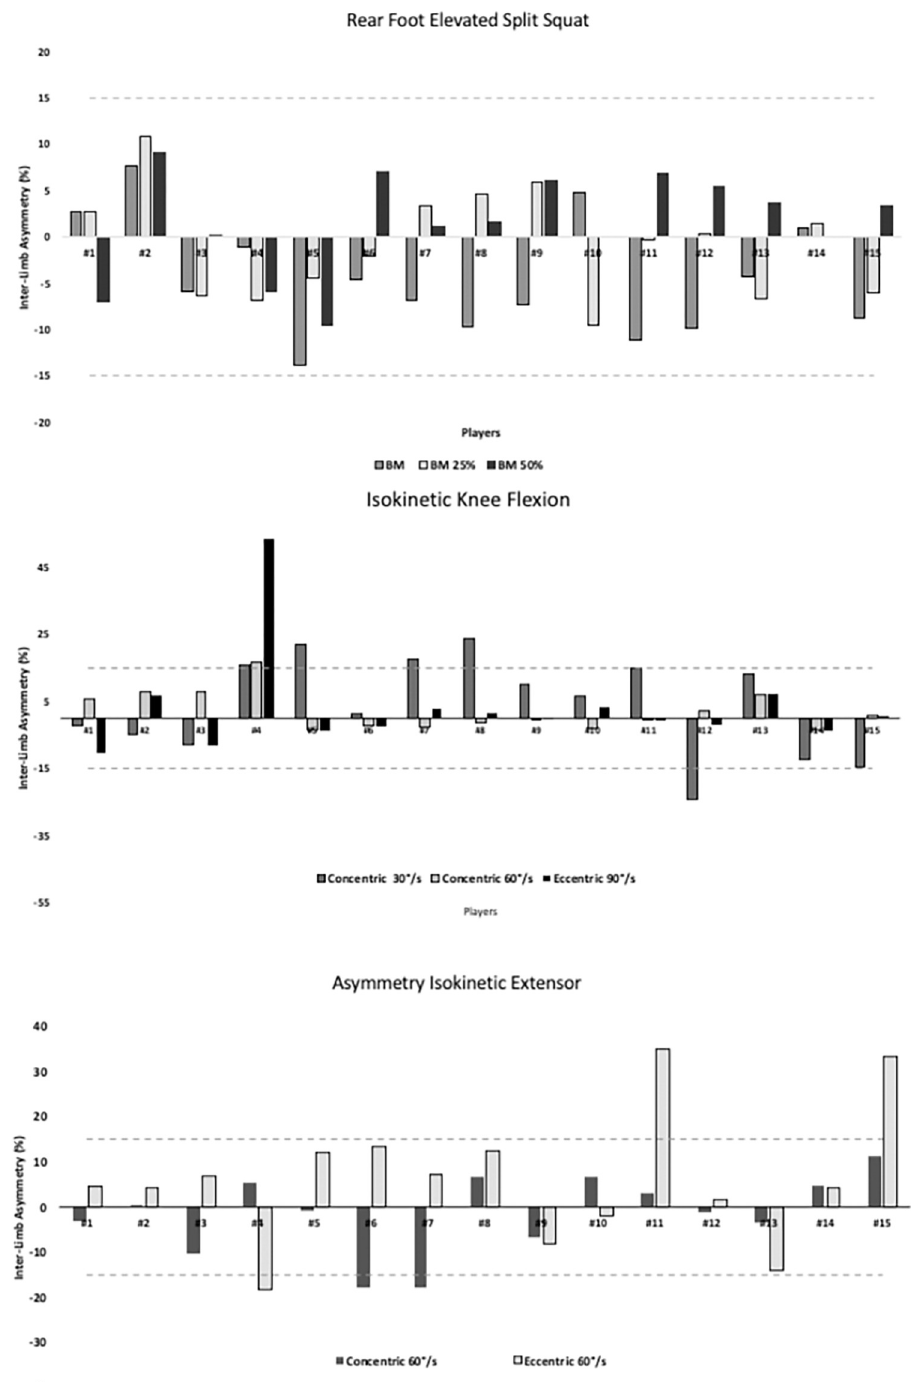
Fig 3. Magnitude and direction of inter-limb asymmetry in Rear Foot Elevated Split Squat, isokinetic flexion and isokinetic extension assessments. BM = Body mass, BM25% = Body mass 25%, BM50% = Body Mass 50%. Note : above 0 indicates asymmetry favours the dominant leg and below 0 indicates asymmetry favours the non-dominant leg.